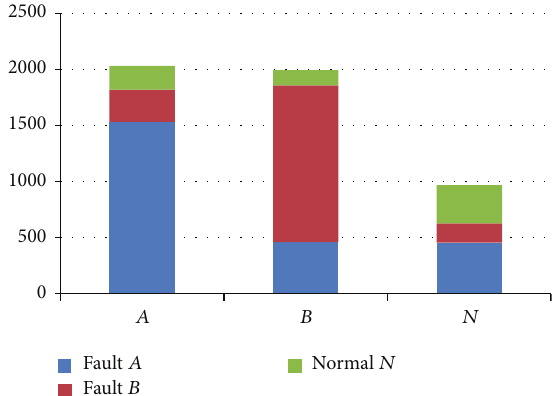
Figure 9: The results using single model to classify multiple faults.